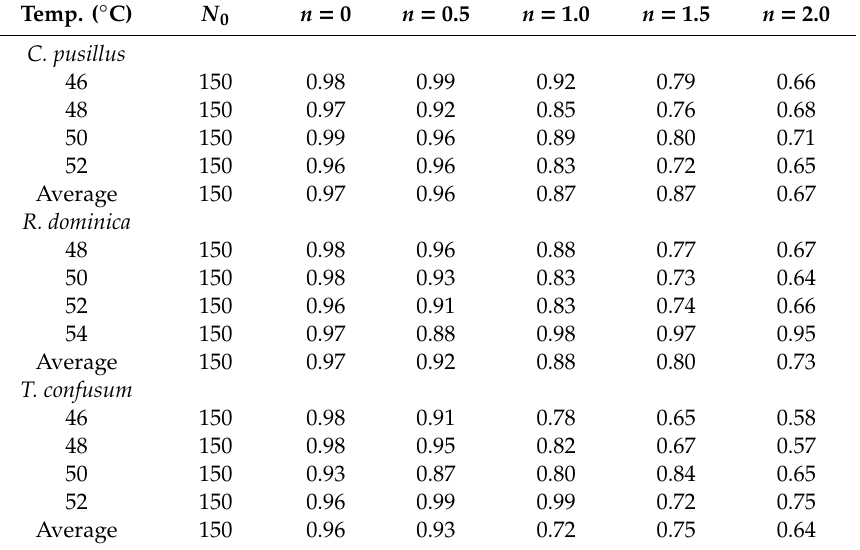
N 0 , the initial number of insects